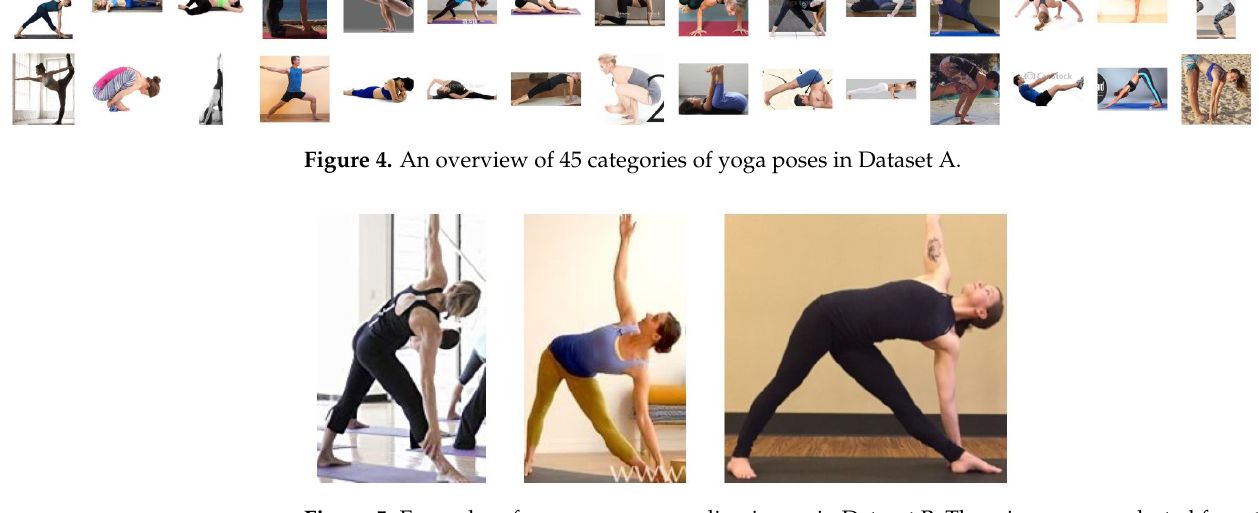
Figure 5. Examples of our yoga pose grading image in Dataset B. Three images are selected from the category Utthita Trikonasana . These images have low , medium , and high grades, respectively (from the left to the